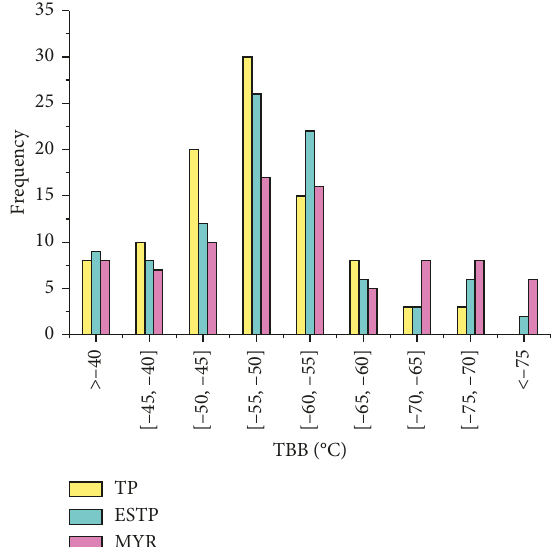
Figure 4: The distribution of TBB on cloudtop with regard to the eastward-moving TPV category cloud clusters over different key regions (light yellow represents TP, light green represents ESTP, light red represents MYR, the X -axis represents TBB (unit: ° C), and the Y -axis represents frequency (unit: